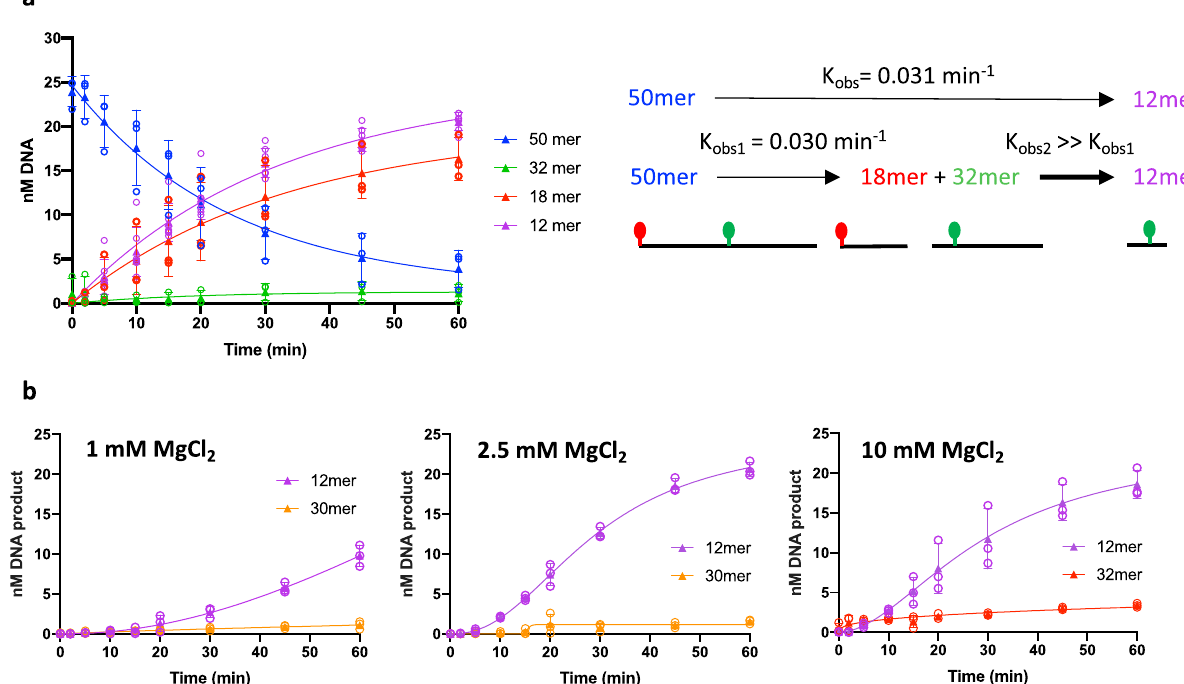
Fig. 4 Kinetics of repair by drUvrABC. a Time-course experiments following the changes in abundance of the different DNA fragments (50 mer in blue, 32 mer in green, 18 mer in red, and 12 mer in purple, illustrated to the right of the graph) as a function of time. The graph presents the mean ( fi lled triangles) and standard deviation of six individual replicates shown as open circles. Reactions were performed at 37 °C using 25 nM F26-seq1 substrate, 1 µ M drUvrA1, 0.5 µ M drUvrB, and 2 µ M drUvrC in the presence of 2.5 mM MgCl 2 . Reactions were started with 2.5 mM ATP. The observed rate of product release, K obs , corresponding to the rate of the dual-incision reaction, was determined to be 0.031 min − 1 by fi tting the 12 mer data points to a single exponential model. The observed rate of 18 mer release, K obs1 , corresponding to the rate of the 5 ′ incision reaction, was determined to be 0.030 min − 1 by fi tting the 18 mer data points to a single exponential model. These fi ndings suggest that the rate of the second incision reaction, K greater than the rate of the fi rst incision. b Effects of MgCl 2 on the kinetics of drUvrABC dual-incision activity. Time-course experiments following the accumulation of the 12 mer product (purple) and the intermediate products, 30 mer (orange), resulting from 3 ′ incision or 32 mer (red), resulting from 5 ′ incision, as a function of time. The graphs present the mean ( fi lled triangles) and standard deviation of three individual replicates shown as open circles. Reactions were performed at 37 °C using 25 nM F26-seq1 substrate, 1 µ M drUvrA1, 0.5 µ M drUvrB, and 2 µ M drUvrC in the presence of 1 mM (left), 2.5 mM (middle), or 10 mM (right) MgCl 2 .